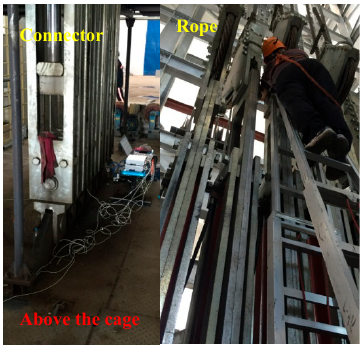
Figure 6. Field test photos.